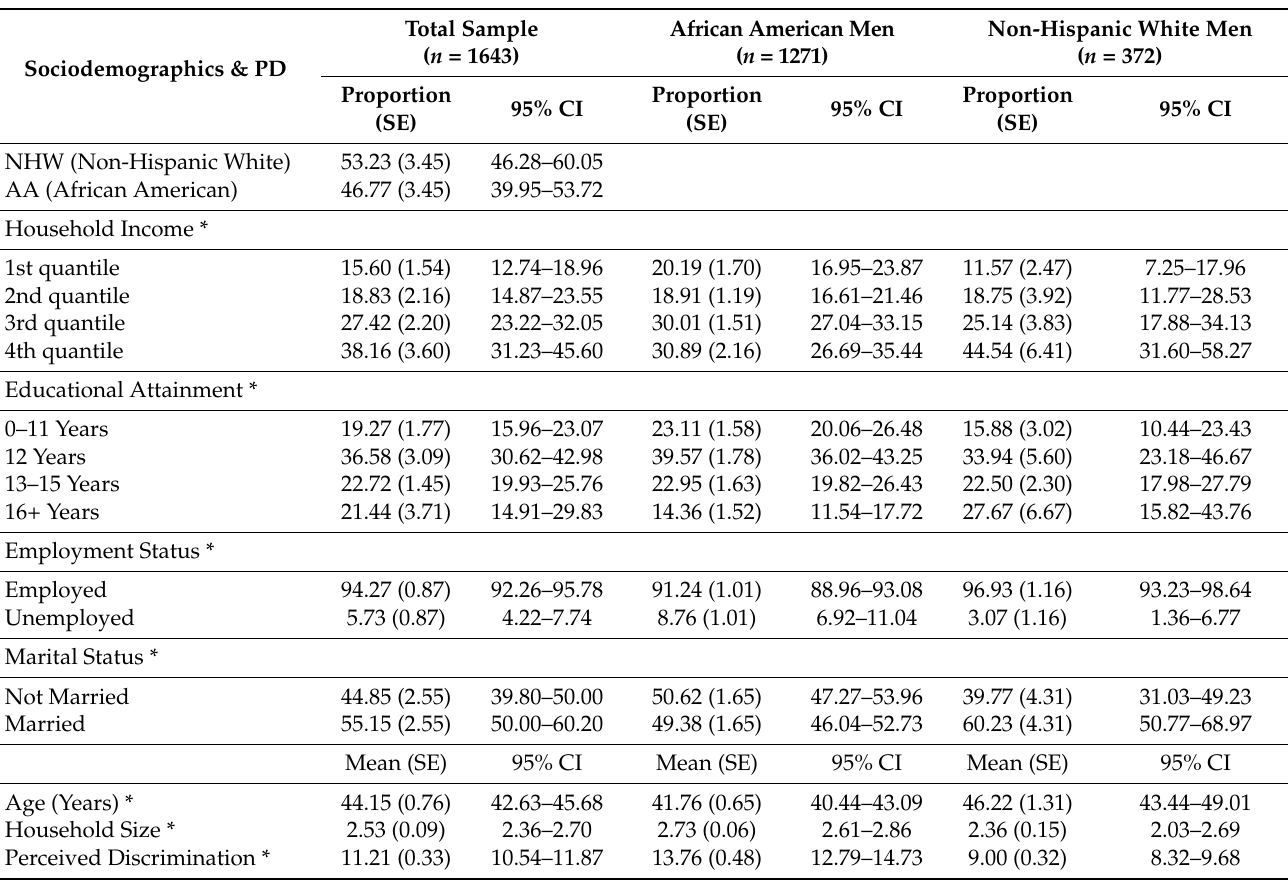
Table 1. Descriptive characteristics in the pooled sample by race among non-Hispanic African American and Non-Hispanic White men in the National Survey of American